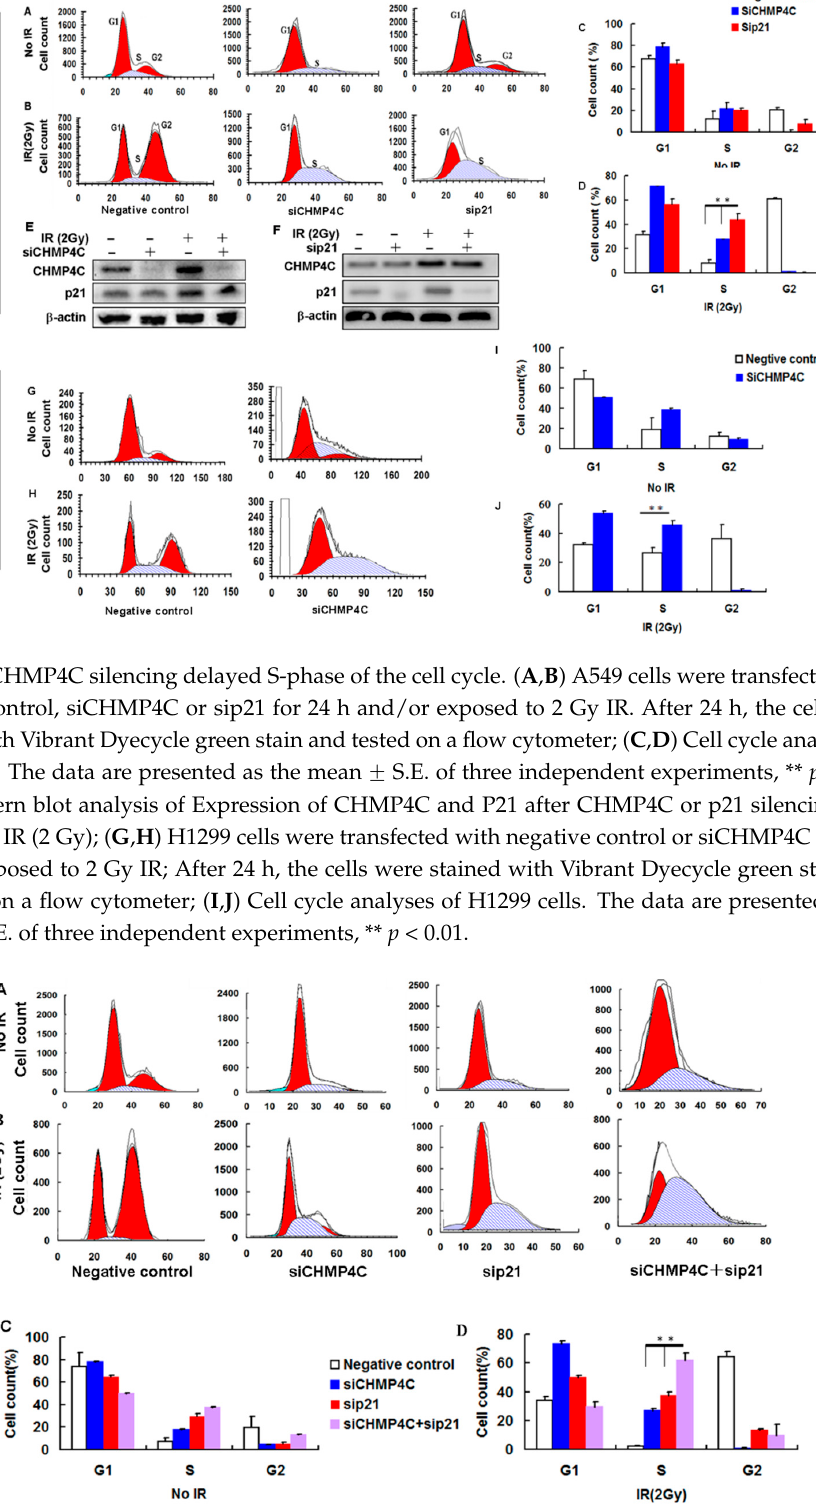
Figure 3. CHMP4C and p21 double silencing exerts an additive effect in S-phase delay of the cell cycle in A549 cells. ( A , B ) A549 cells were transfected with negative control, siCHMP4C, sip21, or double siCHMP4C and sip21 for 24 h and/or exposed to 2 Gy IR. After 24 h, the cells were stained with Vibrant Dyecycle green stain and tested on a flow cytometer; ( C , D ) Cell cycle analyses of A549 cells. The data are presented as the mean ± S.E. of three independent experiments, ** p < 0.05.